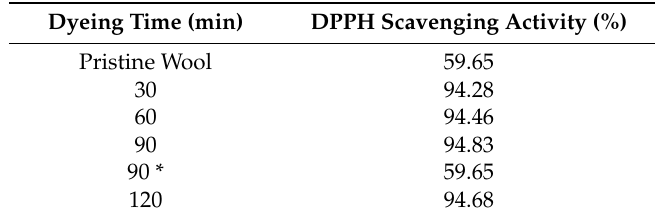
Table 6. Antioxidant activity of wool fabrics dyed with spent coffee extract at 90 ◦ C as a function of dyeing time (all dying samples were mordanted with 1 wt % tannic acid aqueous solution except 90* sample).